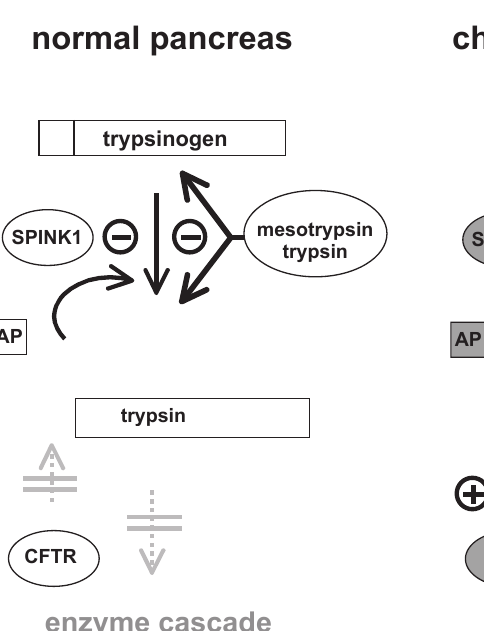
Model of chronic pancreatitis. a. Condition in the normal pancreas: trypsin resulting from autoactivation of trypsinogen within the pancreatic parenchyma is inhibited by SPINK1 and in the second line by mesotrypsin or trypsin. This defence mechanism pre- vents activation of the pancreatic enzyme cascade within the pancreas and auto- digestion. b. Condition in chronic pancreatitis: mutations in PRSS1 or in SPINK1 lead to an imbalance of proteases and their inhibitors within the pancreatic parenchyma, resulting in an inapprop- riate and premature conversion of pan- creatic zymogens to active enzymes with autodigestion and inflammation. Muta- tions in CFTR may disturb this balance by intrapancreatic acidification or by defective apical trafficking of zymogen granules, and thus facilitate intrapan- creatic activation of digestive enzymes. Dark boxes represent products of mu- tated genes. Modified from references 39 and 65. AP, activation